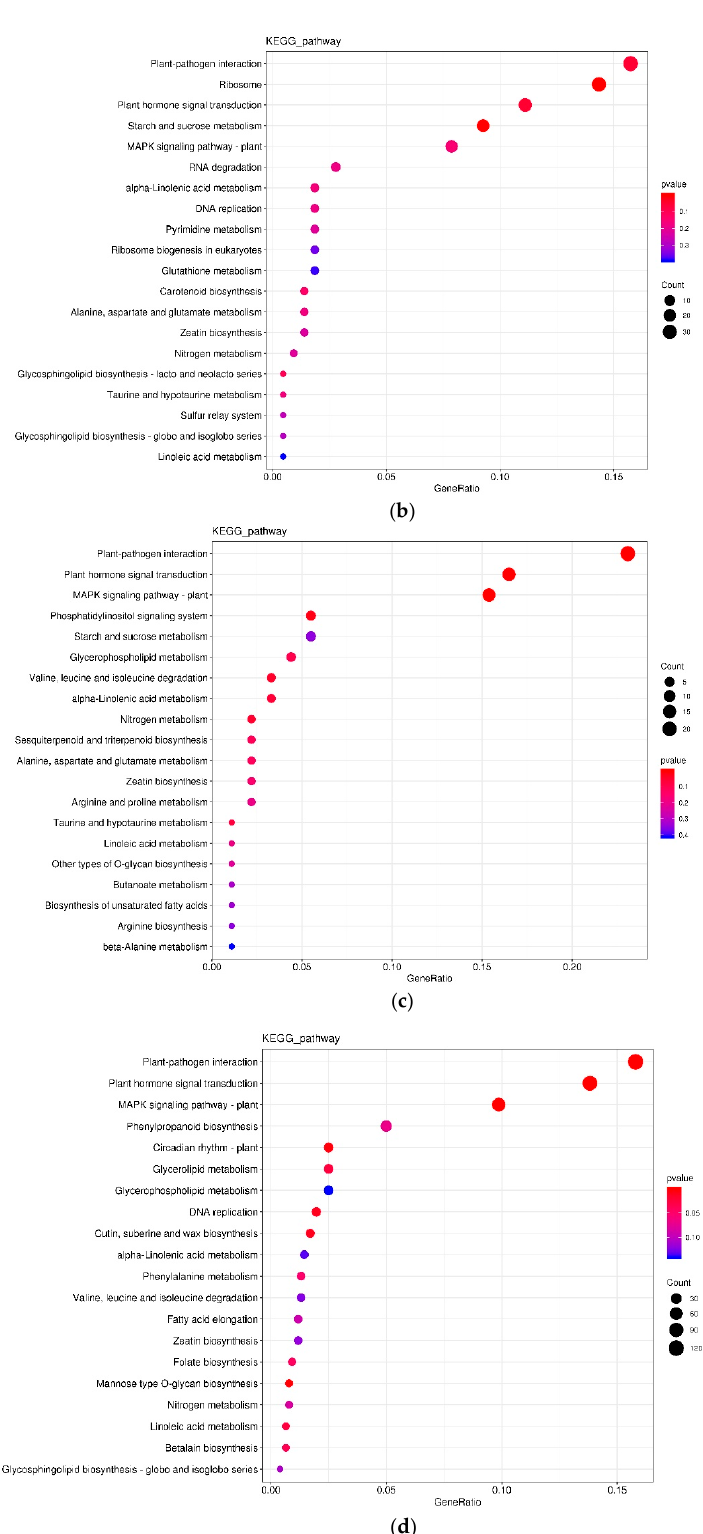
Figure 4. KEGG comparison of DEGs in different treatments. ( a ) 24LP − vs. 24LP+. ( b ) 48LP − vs. 48LP+. ( c ) 24GP − vs. 24GP+. ( d ) 48GP − vs. 48GP+. Fold enrichment, depicted by circle size, which was calculated by GeneRatio/BgRatio; p. adjust, shown by color, indicates significance level of enrichment results from blue to red. KEGG and DEGs indicate Kyoto Encyclopedia of Genes and Genomes and differentially expressed genes, respectively.